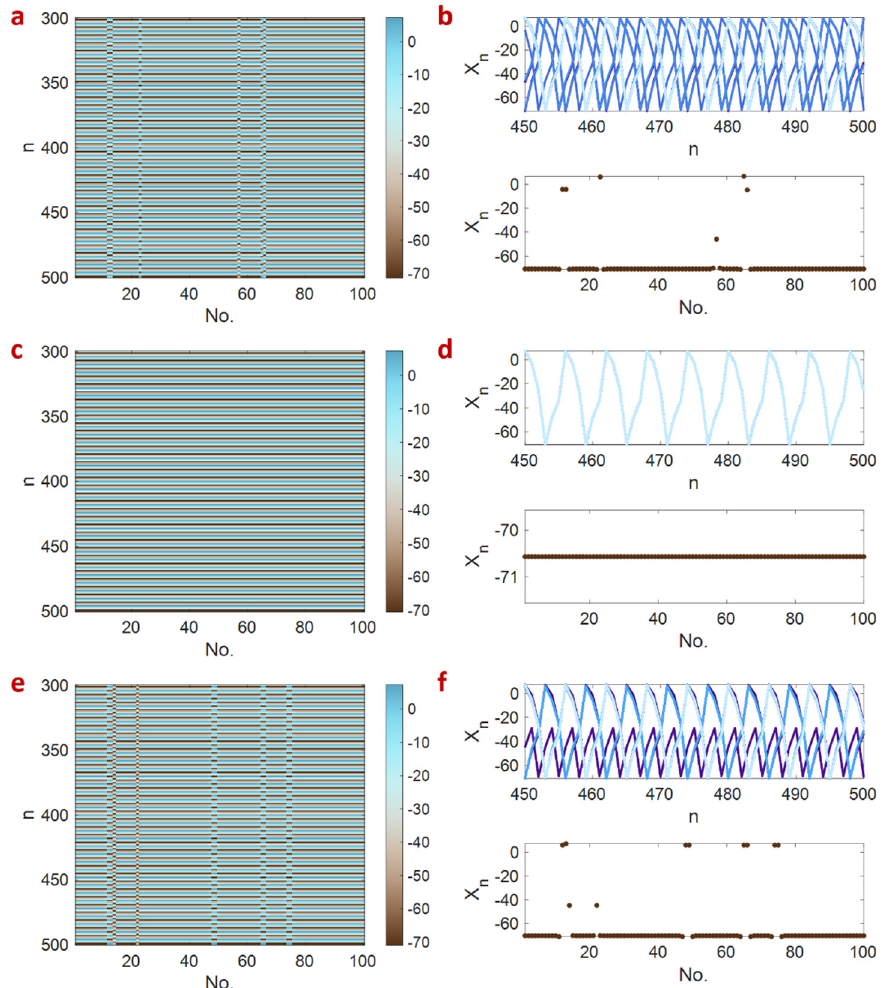
Figure 6. The spatiotemporal patterns (left panel) and the time series and snapshots (right panel) of the network of 100 memristive neuron maps coupled via chemical synapses. ( a , b ) For g c = 0.04, imperfect synchronization is observed. ( c , d ) For g c = 0.044, complete synchronization is achieved. ( e , f ) For g c = 0.06, the solitary state